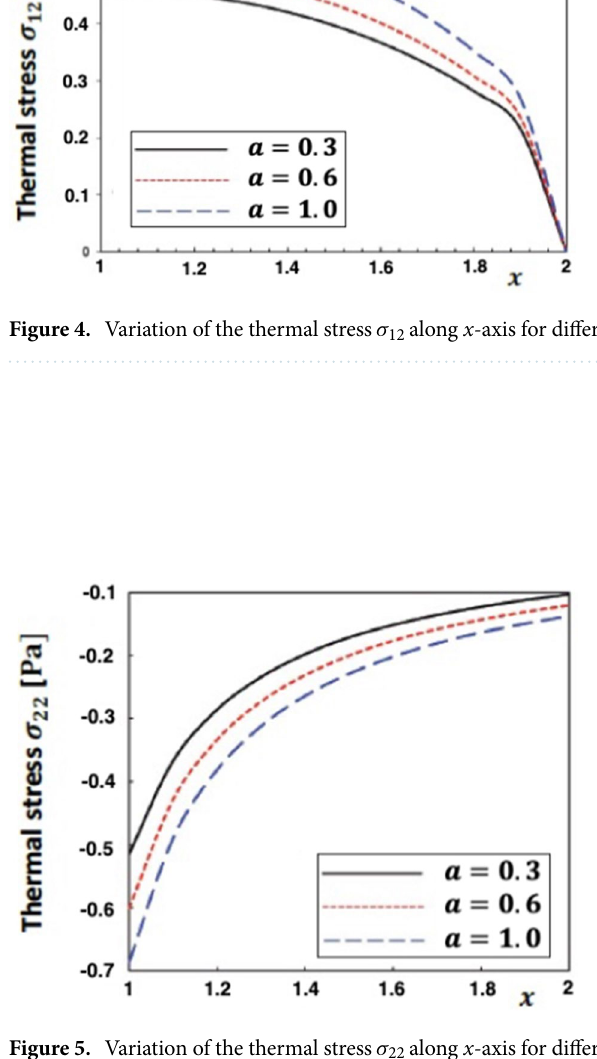
Figure 5. Variation of the thermal stress σ 22 along x -axis for different values of fractional order